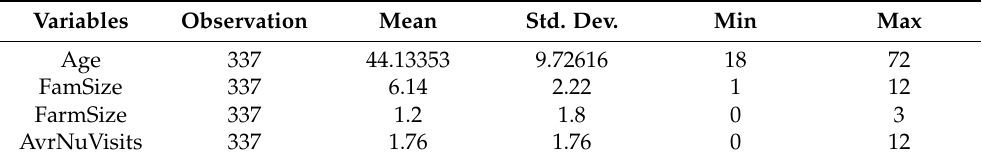
Table 2. Basic Descriptive Statistics of Continuous Variables.